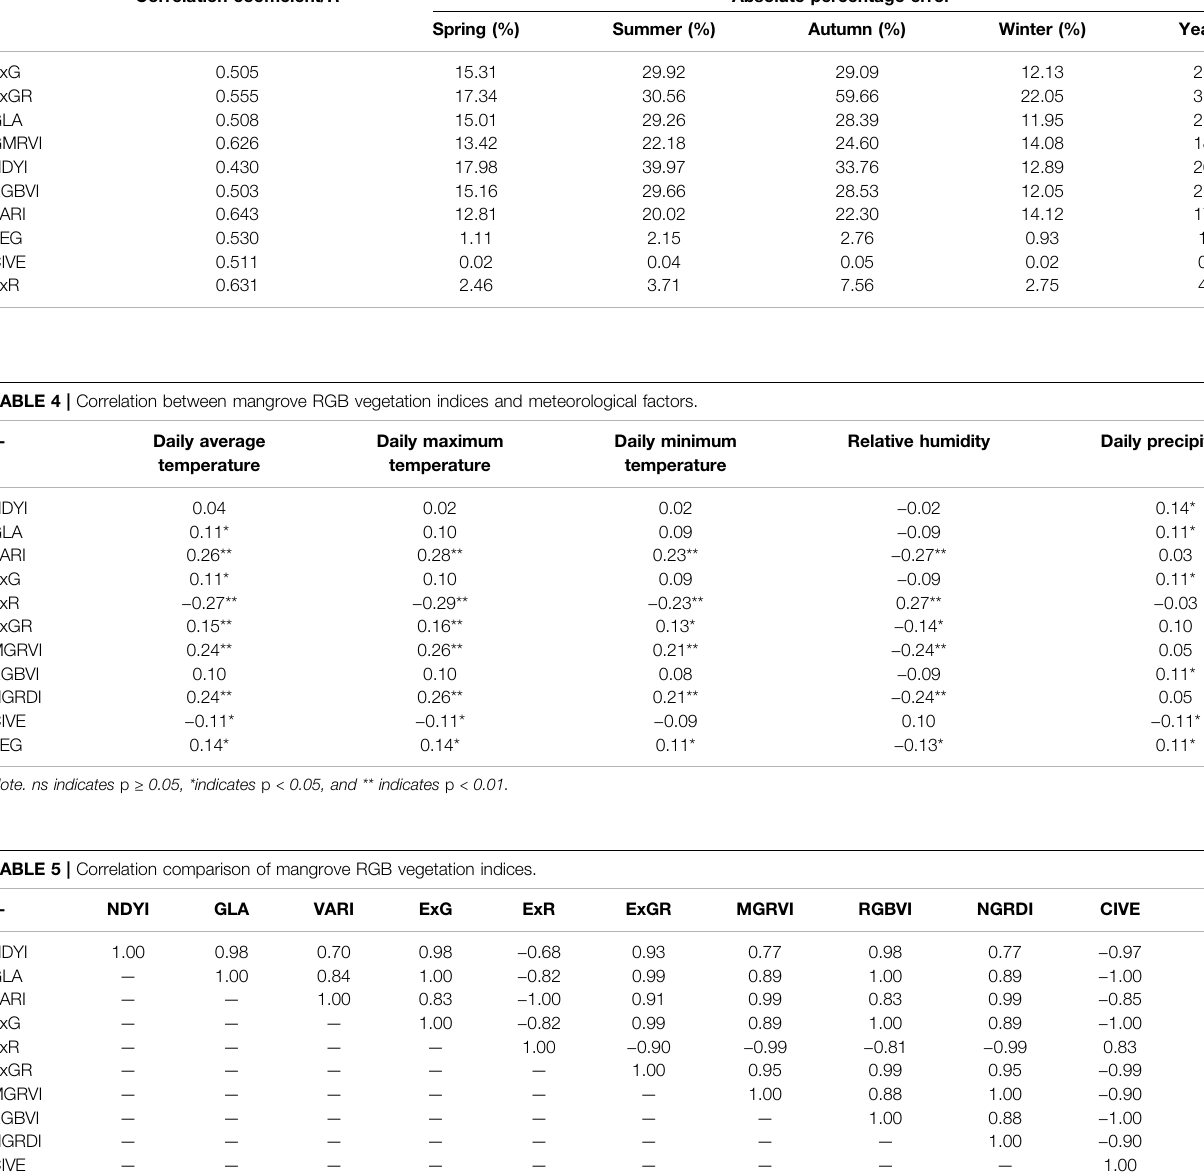
TABLE 3 | Correlation and deviation percentage between fi tted and observed values of mangrove RGB vegetation indices. — Correlation coef fi cient/R Absolute percentage error Spring (%) Summer (%) Autumn (%) Winter (%) ExG